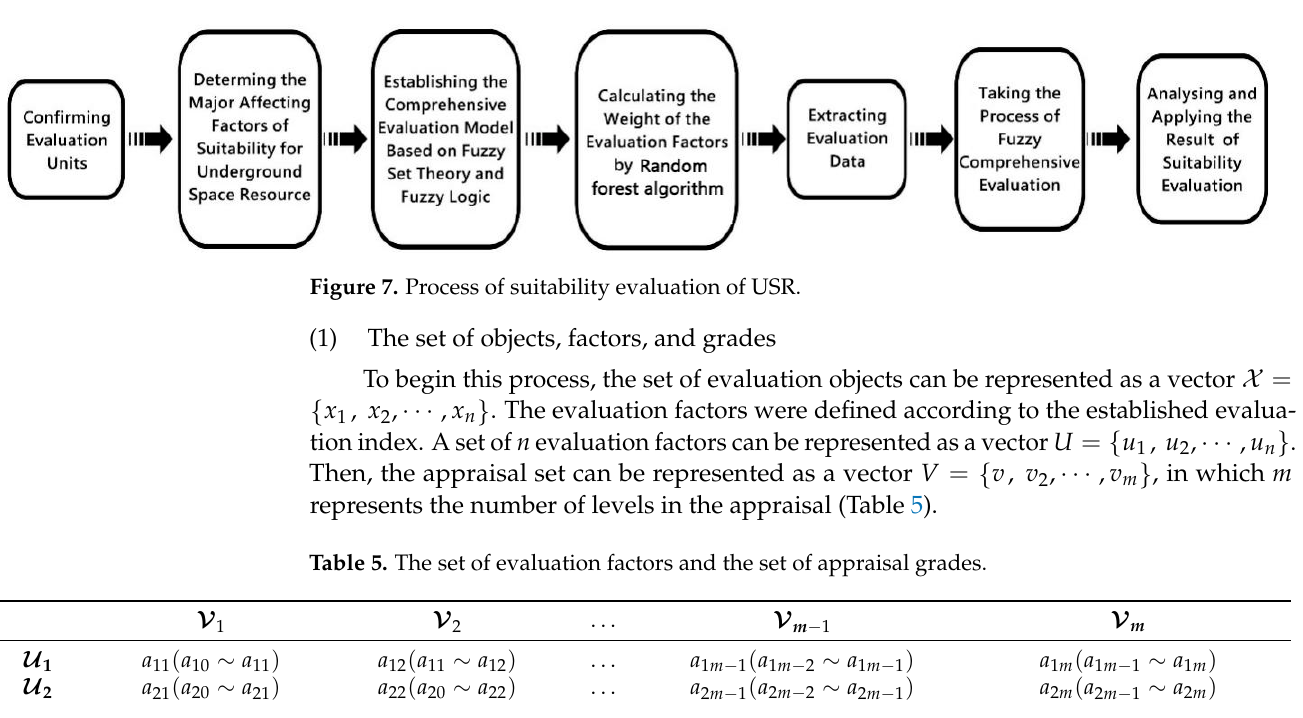
Figure 6. Index weights calculation process.